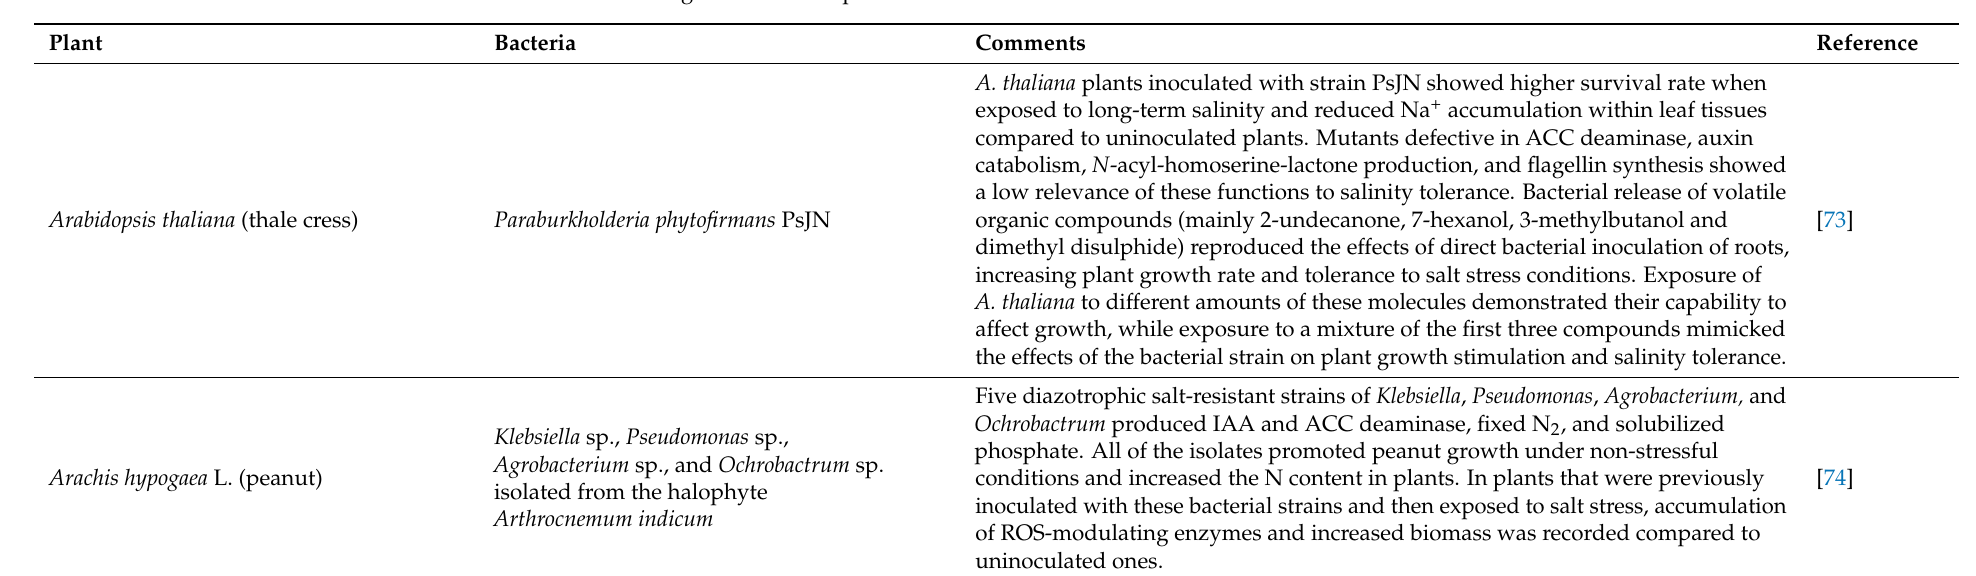
Table 2. Recent studies indicating how PGPB help to ameliorate salt